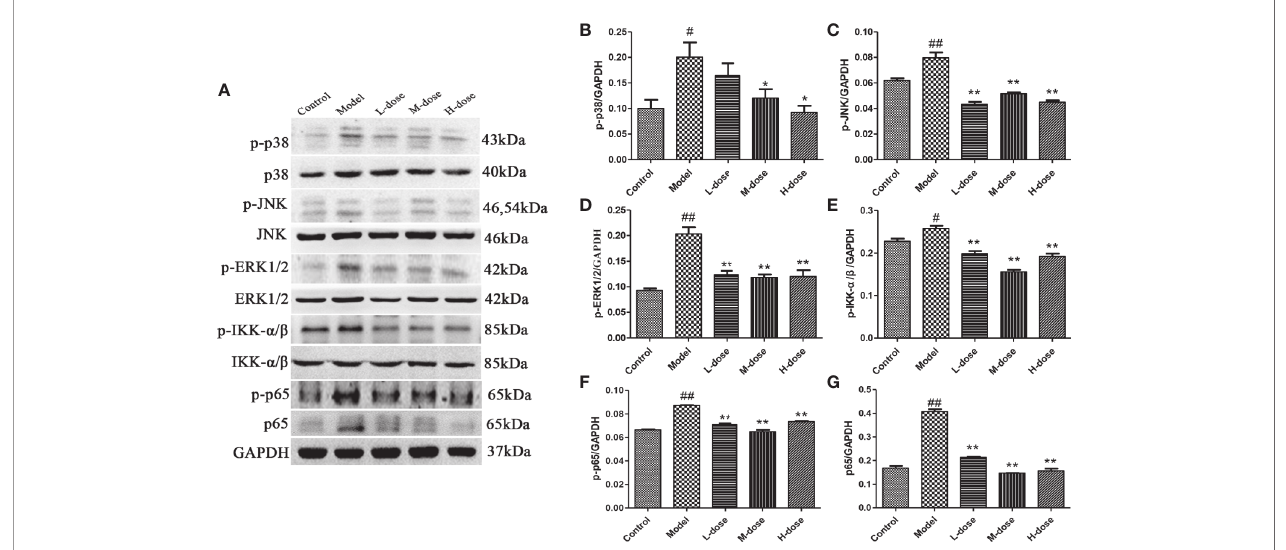
FIGURE 4 | SLBZS regulates the MAPK and NF- k B pathways. (A) The expression levels of p-p38, p-JNK, p-ERK1/2, p-IKK- a / b , p-p65, and p65 were analyzed by western blotting. (B – G) Analysis of protein concentration. The data are shown as the mean ± S.E.M. # P < 0.05, ## P < 0.01 vs. the control group; * P < 0.05, ** P < 0.01 vs. the model